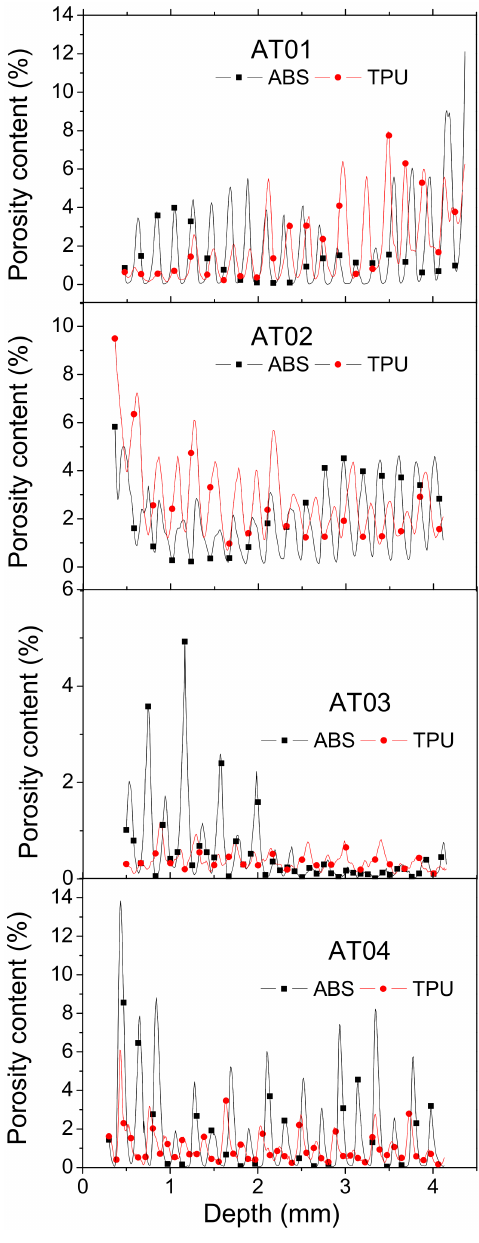
Figure 10. Depth porosity profiles in each phase of the ABS/TPU composite for all printing conditions. The statistics on porosity content within each phase in Table 1 support this